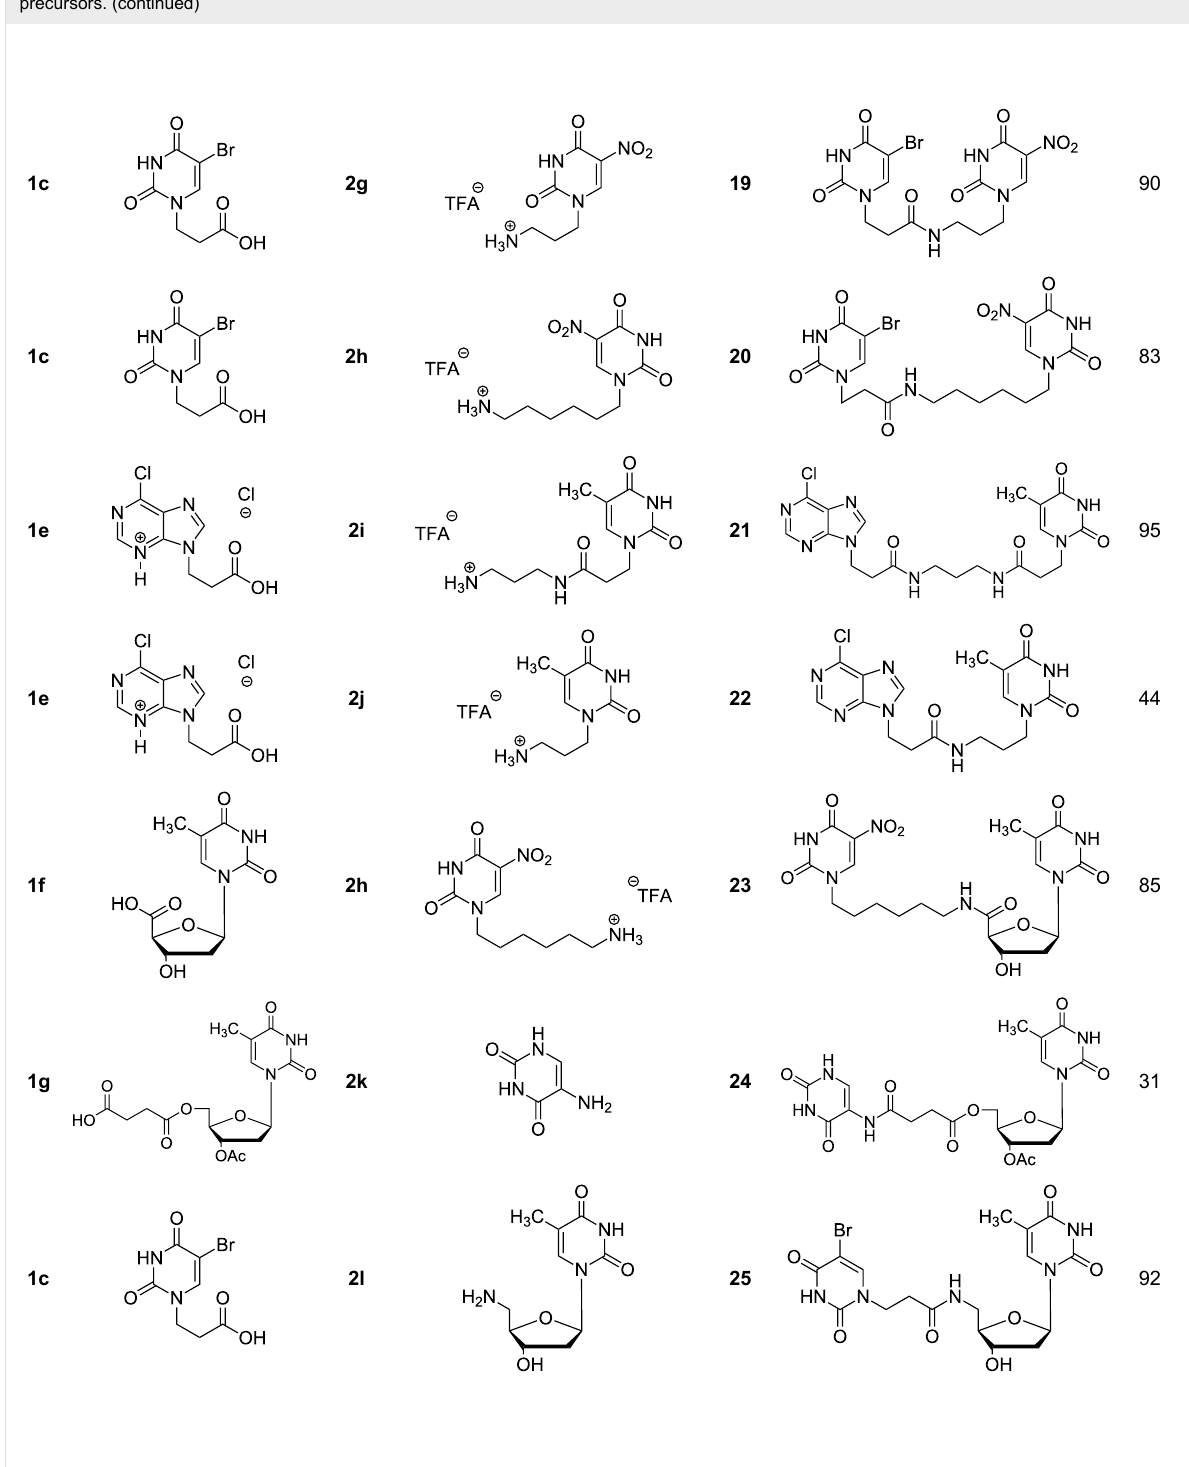
Table 2: Unsymmetrical α , ω -nucleobase amide-conjugated systems based on aliphatic or saccharidic linkages and their exemplary synthetic precursors.